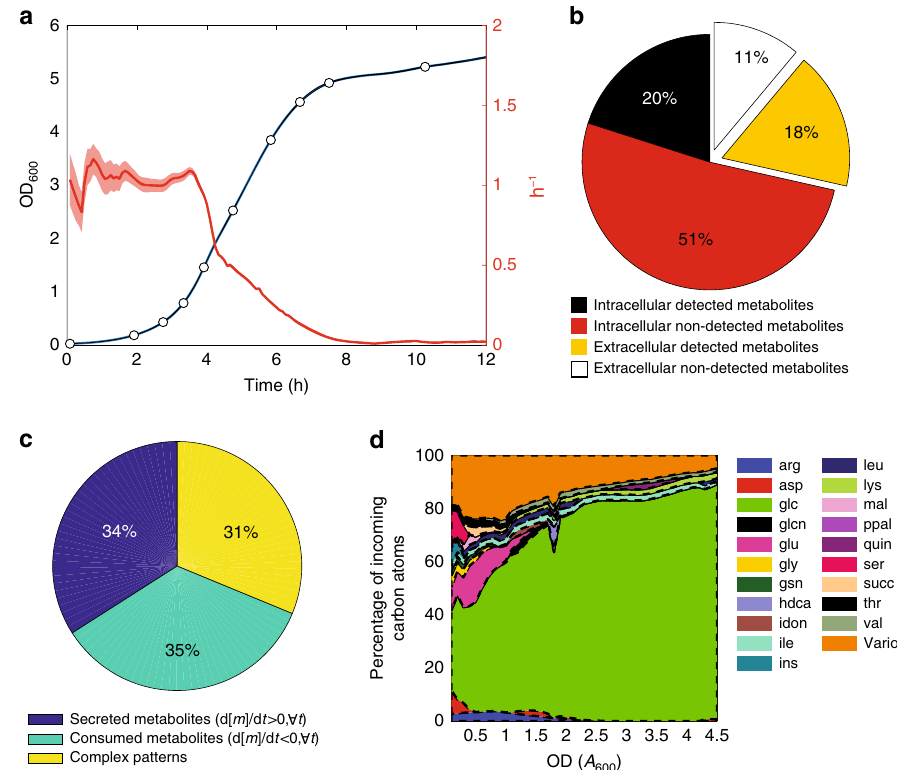
Fig. 1 Exo-metabolome pro fi ling. a Optical densities (OD 600 ; blue line) and instantaneous growth rate — i.e., OD 600 difference between two contiguous time points divided by the time interval (red line), of an E. coli culture growing in M9 glucose minimal medium supplemented with casamino acids (CAA). Dots represent time points for withdrawal of supernatant aliquots for exo-metabolome analysis. The solid line represents the mean across four biological replicates, while the shaded region is the mean ± standard deviation. b Percentage of detected metabolites with respect to the annotated compounds in the genome-scale model of E. coli 25 : metabolites that can be exchanged with the external environment (white and yellow), and those that are constrained to be intracellular (red and black). c Percentage of detected metabolites exhibiting complex (yellow) or monotonic pro fi les, i.e., instantaneous derivative in time is always negative (green — consumed) or positive (blue — secreted). d The total incoming fl ux of carbon at each given time is calculated by multiplying the number of carbon atoms for each compound and the respective estimated uptake fl ux. The relative percentage is reported. Only those metabolites contributing for at least 2% of the total incoming carbon are listed. The remaining compounds are grouped (i.e., Various in the legend). Correspondence between metabolite IDs in the legend and metabolite names can be found in the Supplementary Data